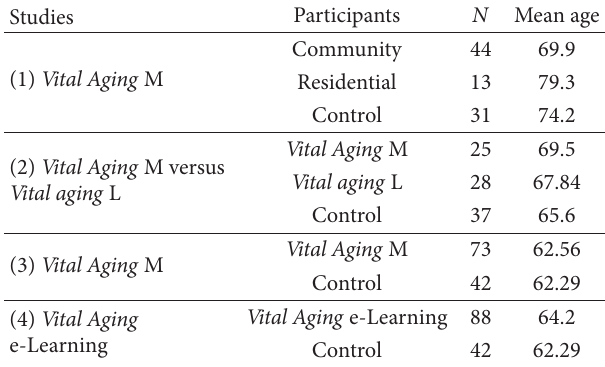
T 3: Sample Characteristic of the four studies curried